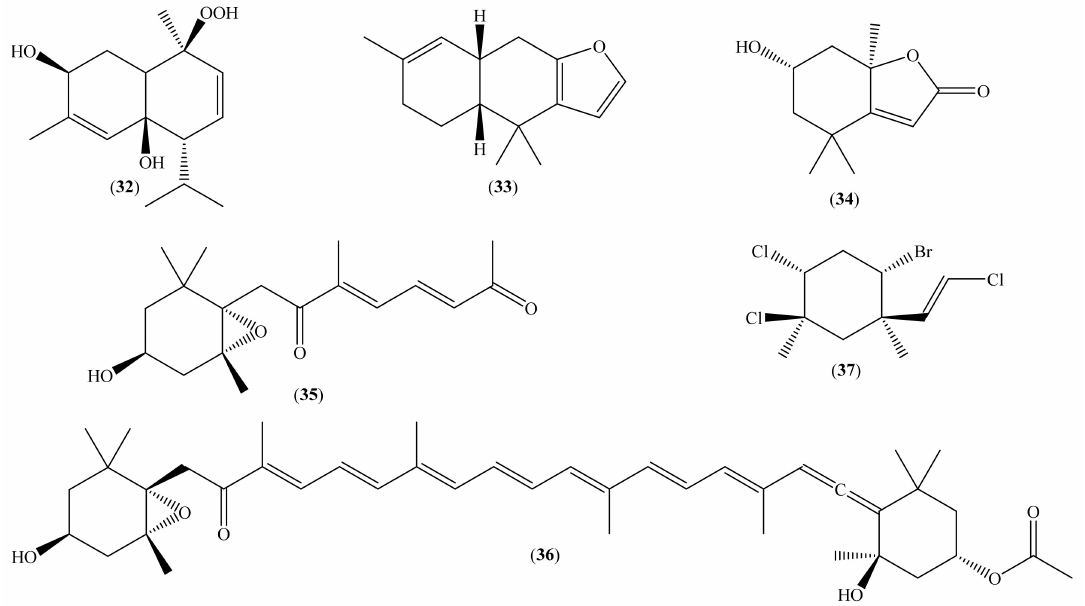
Figure 4. Chemical structure of other terpenoids isolated from marine